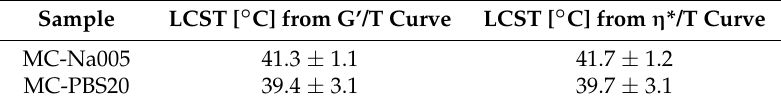
Table 2. Values of the sol/gel transition temperature (lower critical solution temperature (LCST)) for MC-Na005 and MC-PBS20. The sol/gel transition temperature was determined by the temperature sweep tests.